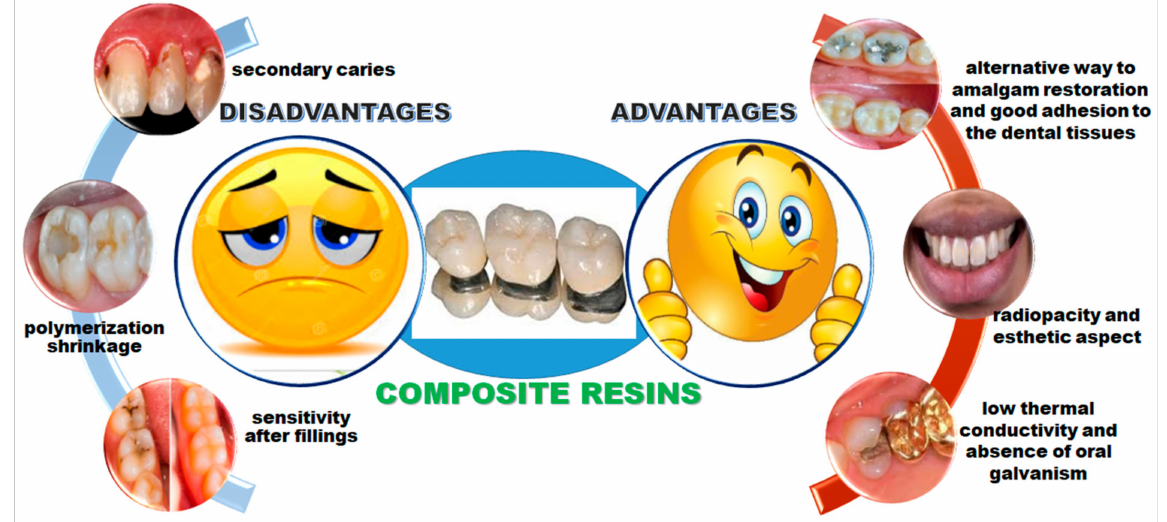
Figure 4. Advantages and disadvantages of composite materials used in dental